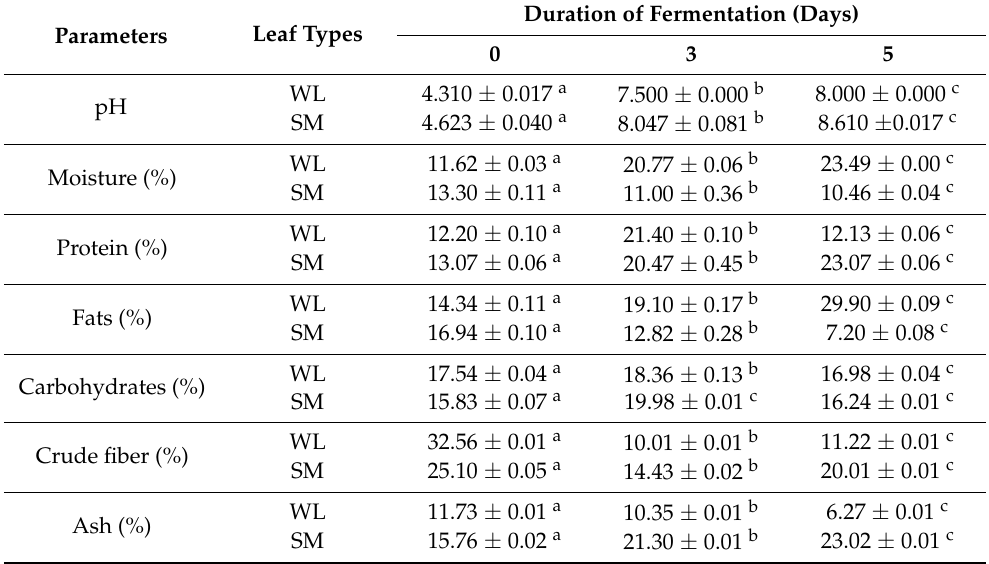
Table 1. pH and proximate contents of fermented leave extracts from S. monostachyus and T. fruticosum